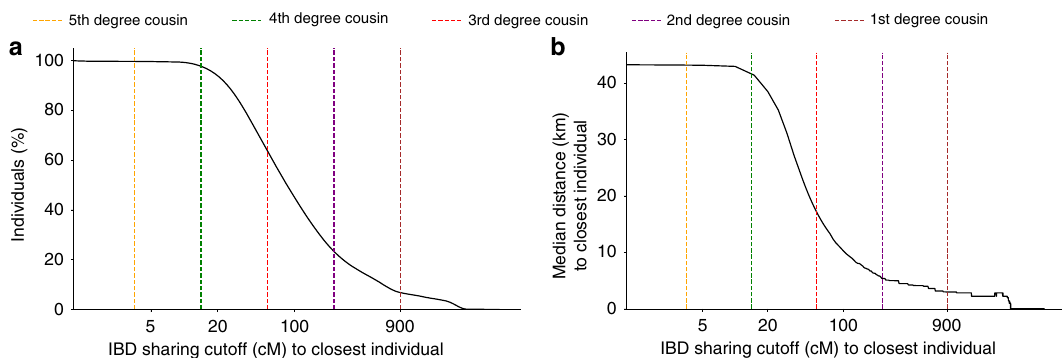
Fig. 3 Genetic relatedness and geographic distances in the UK Biobank dataset. For each of the 432,968 UK Biobank samples with available geographic data, we detected the individual sharing the largest total amount (in cM) of genome IBD within the past 10 generations (referred to as closest individual). a For each value x of total shared genome (in cM) on the X -axis, we report the percentage of UK Biobank samples ( Y -axis) that share x or more with their closest individual. b For each value x of total shared genome (in cM) on the X -axis, we report the median distance (km, computed every 10 cM) for all pairs of (sample, closest individual) who shared at least x . Vertical dashed lines indicate the expected value of the total IBD sharing for k th degree cousins, computed using 2 G (1/2) 2( k + 1) , where G = 7247.14 is the total diploid genome size (in cM) and k represents the degree of cousin relationship (e.g. k = 2 for second degree cousins, separated by 2( k + 1) generations) 11 . The value of 45 observed when no sharing cutoff is considered (i.e. when the x value approaches 0) re fl ects the median prediction error for a random individual, regardless of how much IBD they share with the closest